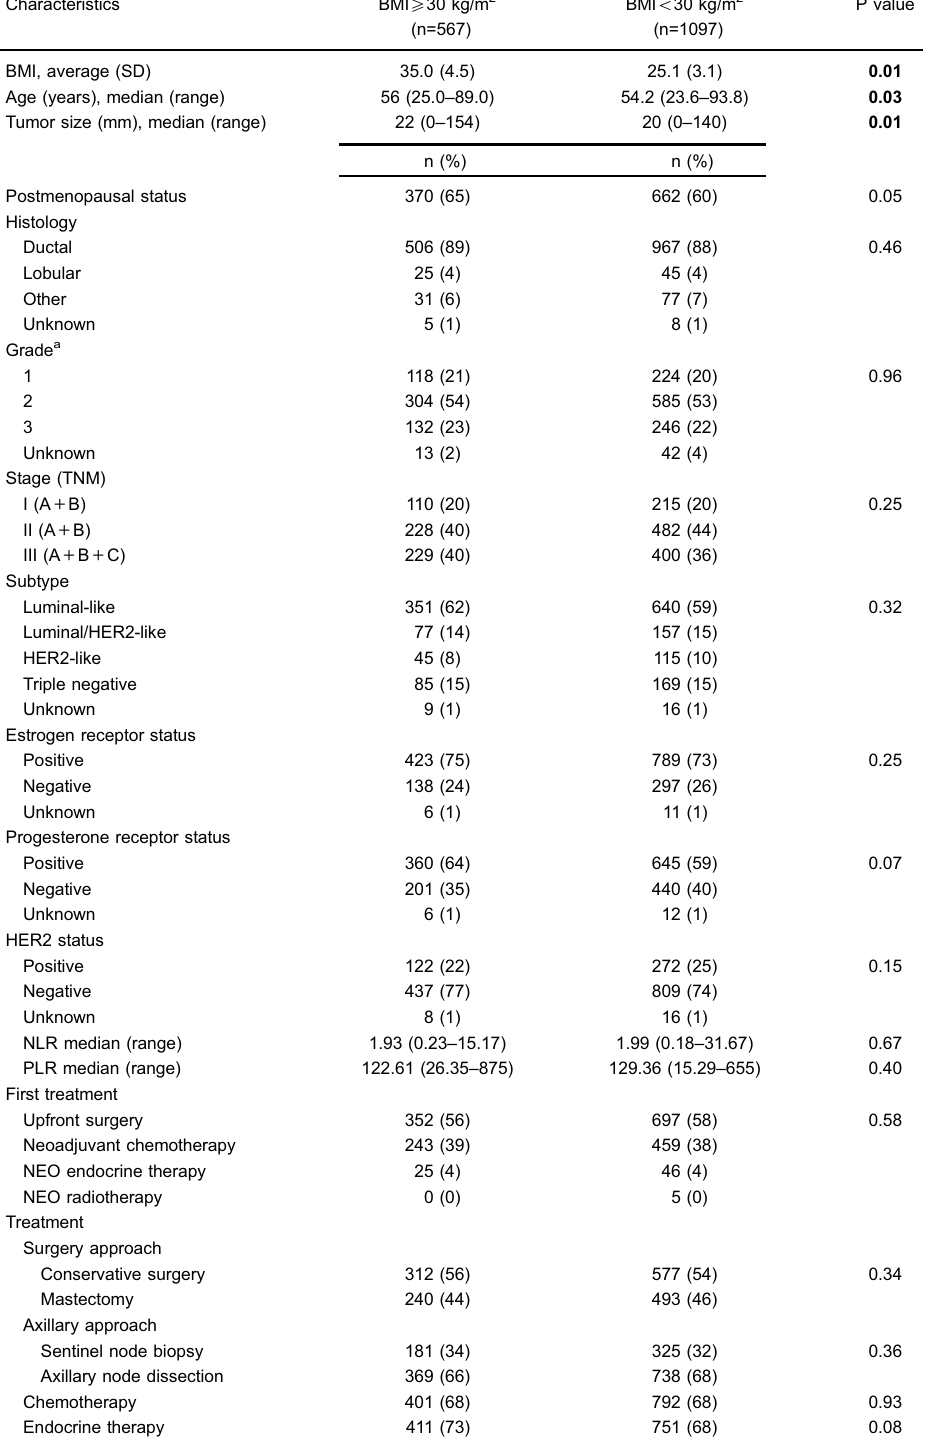
Table 1. Baseline characteristics of all patients with breast cancer (n=1664), strati fi ed by the body mass index (BMI).